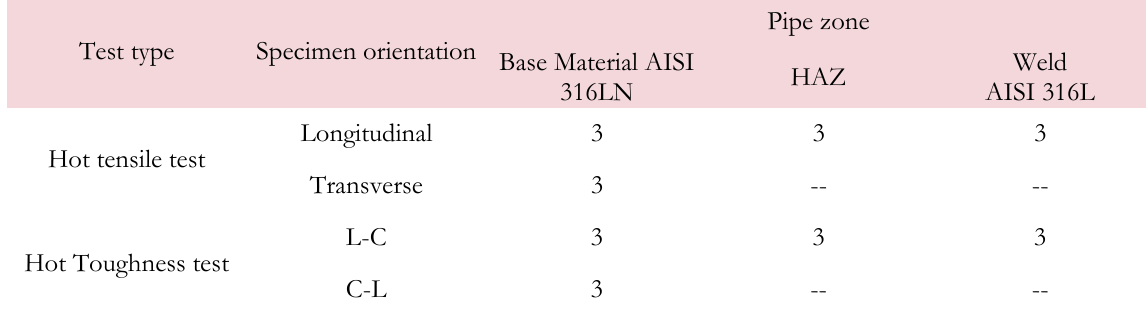
Table 1: Quantity of specimens for hot tensile and toughness